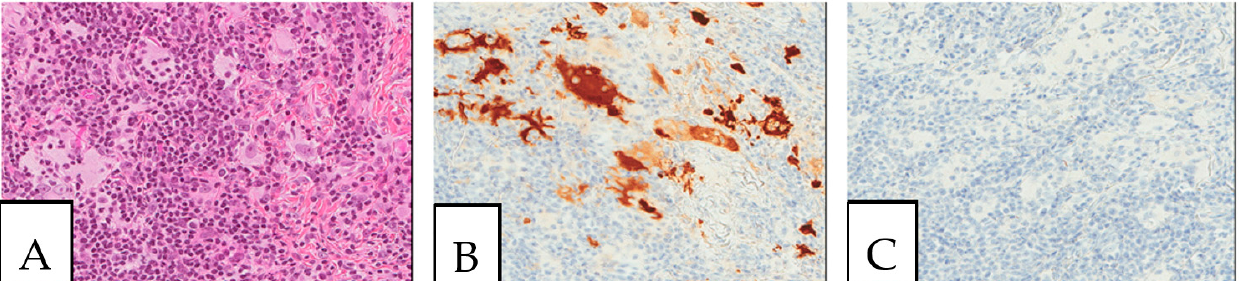
Figure 5. Langerhans cell histiocytosis. ( A ) . Cutaneous Langerhans cell histiocytosis with characteristic coffee bean-like cells ( B ) . CD1a-positive tumor cells. ( C ) . S100-positive tumor cells. The patient was a young female adult presenting with multiple skin lesions, whose biopsy is shown here.